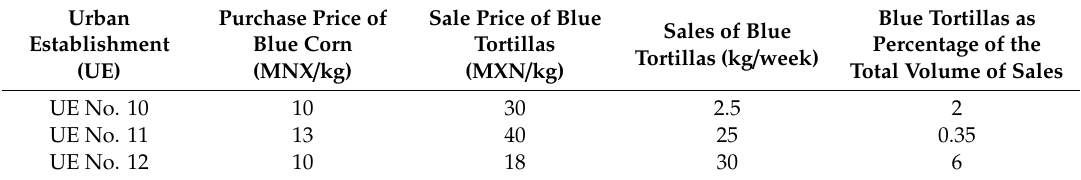
Table 2. Characteristics of blue comal tortillas in the urban area of